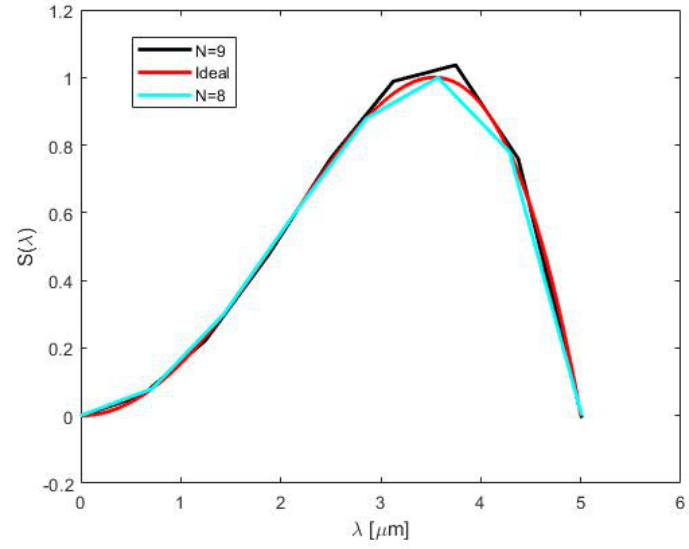
Figure 4. Spectral response function reconstruction with Laguerre